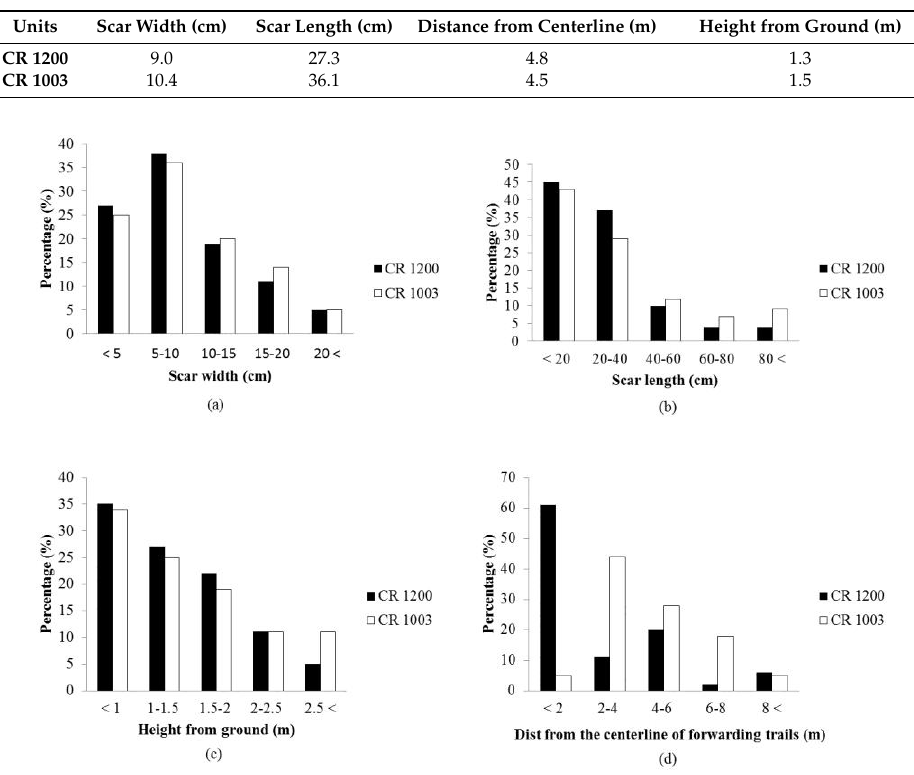
Figure 2. Scar distribution percentage as related to ( a ) width and ( b ) length, ( c ) height from ground, and ( d ) distance from centerline of forwarding trail for each unit.